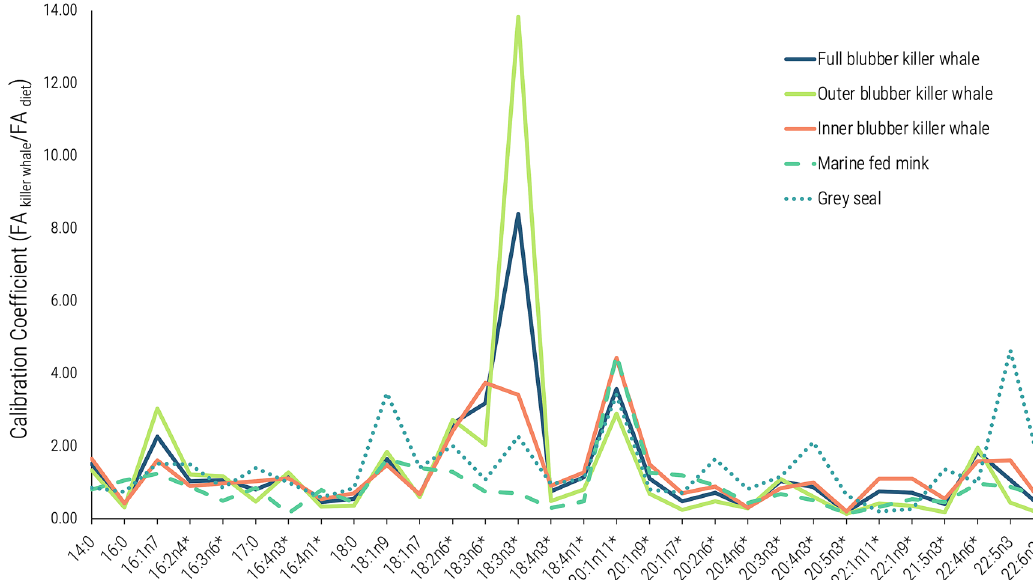
Figure 1. Calibration coefficients (CCs; ratio of each FA in the predator to that in its diet) used in the QFASA simulations for cetaceans. Killer whale CCs were calculated from four managed-care killer whales and their known diet species in the current study, while the grey seal CCs and the marine-fed mink CCs were reported previously (Iverson et al. 2004; Thiemann et al. 2008). CCs shown here include all dietary (with asterisk) and extended dietary FAs that were greater than 0.1% of total FAs. Dietary FAs only arise from the diet, while extended dietary FAs also include FAs partially biosynthesized by the the full depth blubber using the function pred_beyond_prey showed that 39.3% of the predator FA were outside the range of prey FA without CCs. In contrast, with CCs derived from the managed-care killer whales on the dietary FA set, only 11.9% of the predator FAs were outside the range of prey FAs, indicating an appropriate set of CCs and prey library. The other assumption of QFASA ( i.e. : quality of the prey library) was tested using the leave_one_prey_out (LOPO) function on the dietary FA sets and resulted in between 84.4% and 91.2% of correct species attribution on average (KL and Aitchison distance, respectively). The extended dietary FA set (n = 30) scored similarly in the LOPO analysis, between 87.2% and 91.8% on average (Kullback–Leibler (KL) and Aitchison distance, respectively) (Table S4). The extended dietary FA set scored higher in the pred_beyond_prey (17.0% of predator FA outside the prey FA range), which indicates a poorer fit. Thus, although relatively similar, we selected the dietary FA set (n = 21) for subsequent analyses. Killer whale CCs were necessary to estimate the managed-care killer whales’ diet accurately. The need for these CCs was visually supported by a PCA run on the dietary FA set for the managed-care killer whales and their prey, using various CCs (including no CCs) applied to the full blubber FA signatures (Fig. 2). Indeed, figure 2 demonstrates that applying full depth CCs to the full depth FA signatures put the predator FA signatures into the prey FA range, while no CCs or CCs from seals or mink left the full depth FA signatures well outside the prey range. Moreover, QFASA simulations on the four managed-care killer whales using no CCs resulted in a large overestimation of herring in their diets (Table S5) as herring reached a mean of 100% in the modeled diet for each killer whale, compared to 60% in their true diet. CCs calculated for non-cetacean species were also not successful at estimating the diets of the managed-care killer whales. The mink and grey seal-derived CCs showed, on average, 80.7% error compared to the true diet when the full blubber FA signatures were used, and 102.8% error using outer blubber FA signatures. Mink and grey seal CCs were only somewhat better at estimating the diets based on the inner blubber FA signatures (55.3% error) (Table S6). The CCs from these other species over- estimated the proportion of herring (76.1% herring on average) and underestimated the proportion of capelin (16.6% on average) in the diet of the managed-care whales, especially when used on the full blubber and outer blubber FA signatures. Thus, we chose to only use CCs derived from killer whales for remainder of the study. Diet estimates showed good accuracy in the cross-validation tests. ( i.e .: running the model on two of the four managed-care killer whales, using the average CCs from the two other whales, thus running six different simulations per layer; Table S7). The average diet estimates were accurate (18.0% error with the KL distance, and 25.1% error with the Aitchison distance), with estimates for capelin and herring being very close to the true diet: 35.2 ± 7.33 (vs. 32%) for capelin and 59.1 ± 8.9 (vs. 60%) for herring (KL distance). Two-by-two comparisons for the inner blubber yielded accurate estimates (6.3% error with the KL distance vs. 39.6% with the Aitchison distance). Similarly, two-by-two comparisons for the outer blubber resulted in more accurate estimates with the KL distance (23.3% error with the KL distance vs. 30.2% with the Aitchison distance; Fig. 3, Table S7). Although both statistical distances resulted in accurate diet estimates, the KL distance was selected as it resulted in more accurate estimates than the Aitchison distance when used with killer whale CCs. Additionally, diet estimates computed using the KL and CC means from the four whales were closer to the true diet than